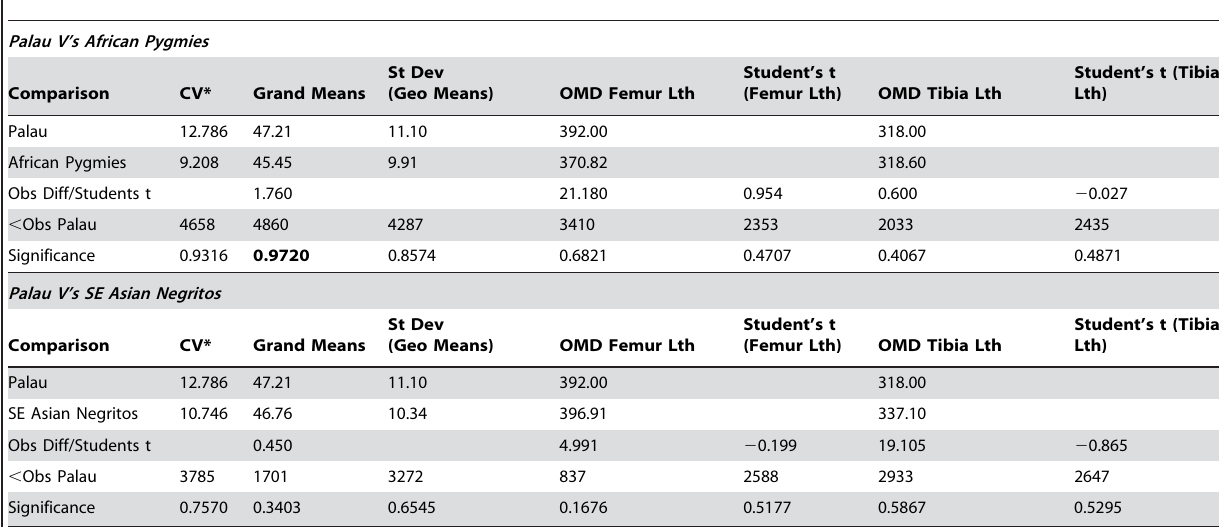
Table 4. Resampling models for Palau